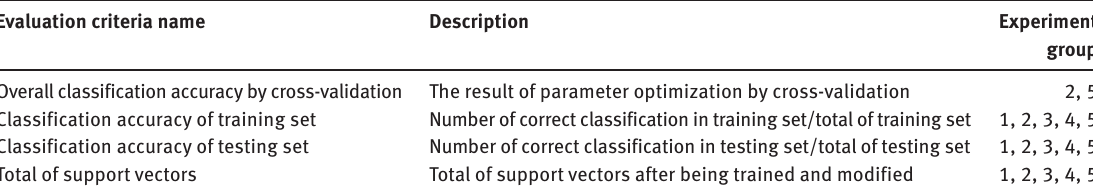
Table 3: Model Evaluation Criteria.